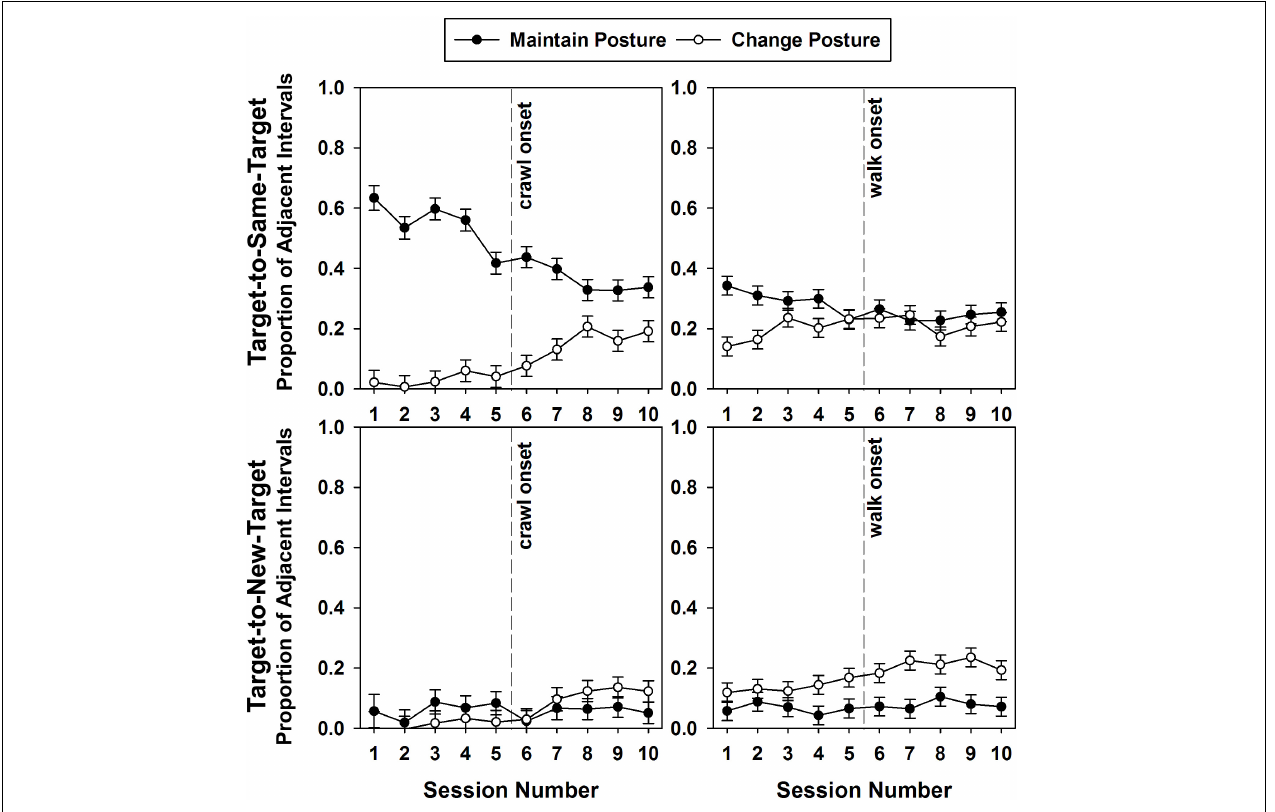
FIGURE 10 | Mean proportions and standard errors of infants’ target-to-same-target (top) and target-to-new-target (bottom) transitions as a function of corresponding posture transitions by session number. The graphs represent the 10-session transition to crawling (left) and walking (right), with the vertical lines indicating the onsets of crawling and walking,